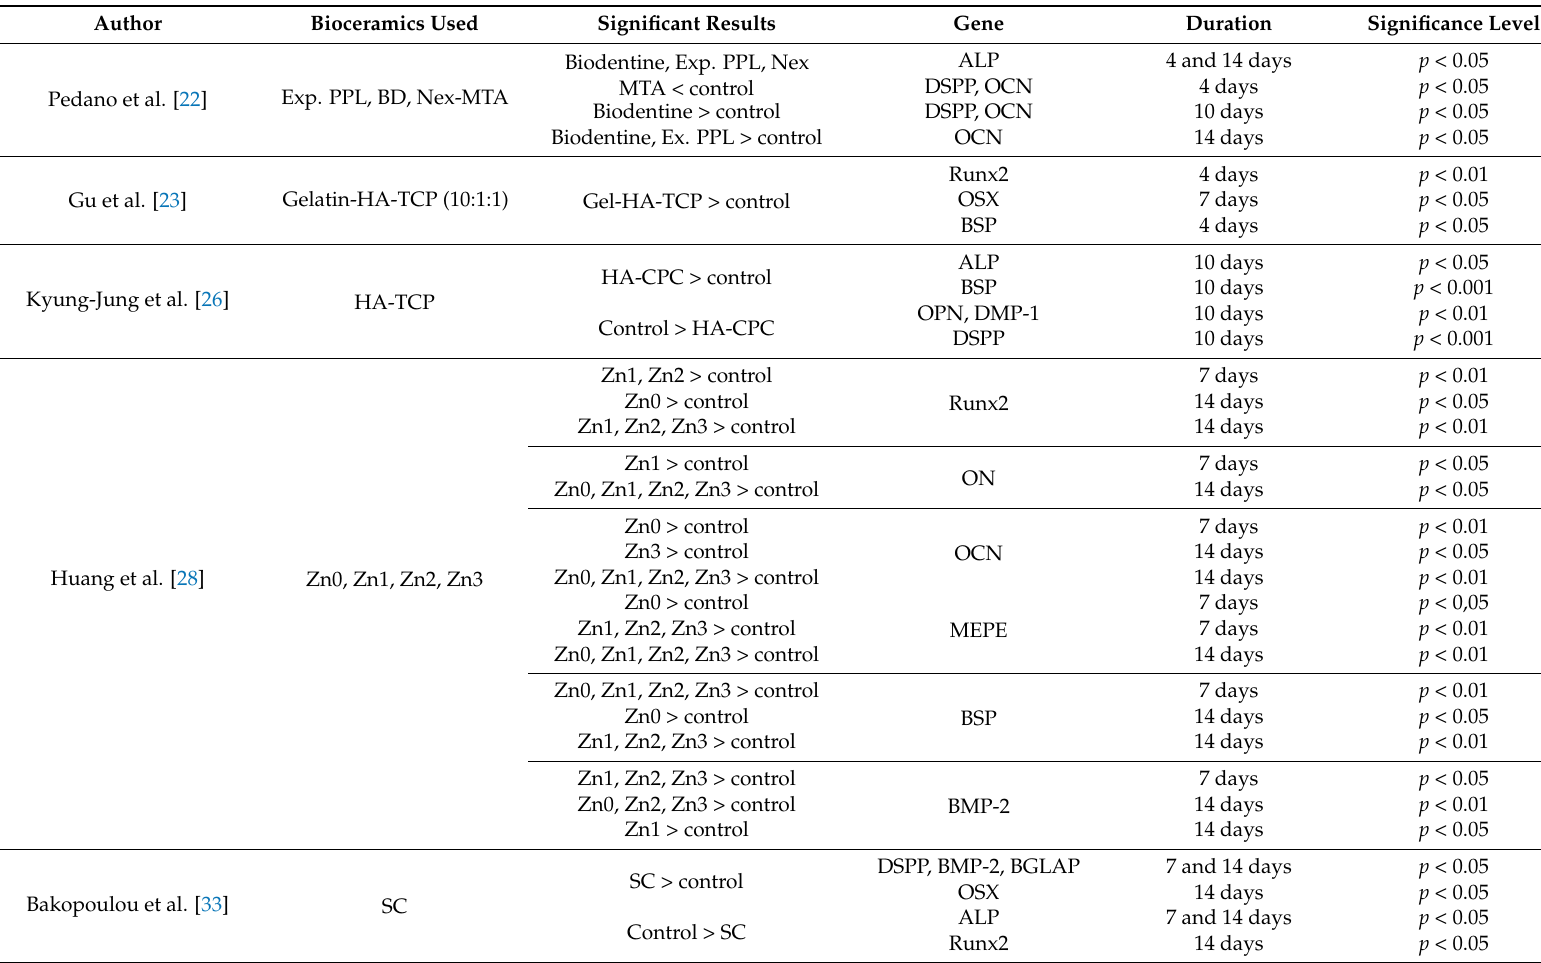
Table 9. Summary of the results of included studies showing significant differences between a bioceramic material and a control for osteogenic, odontogenic and/or angiogenic gene